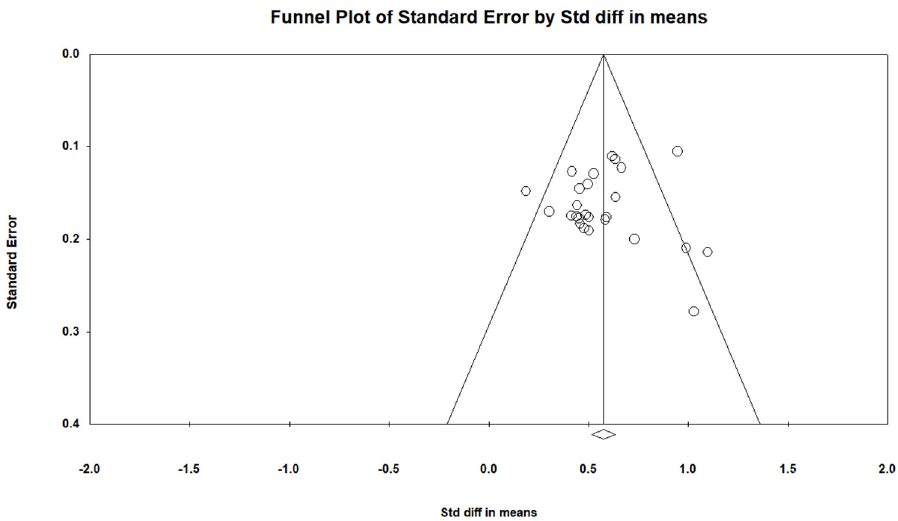
Figure 7. Funnel plot for